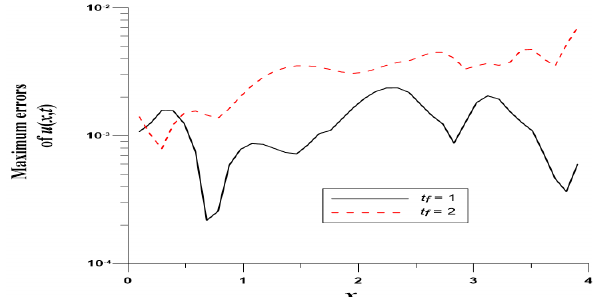
Figure 13. For Example 8 of the backward nonlocal wave problem of the Klein–Gordon equation under two-side nonlocal BCs: ME( u ) versus x with different final times.